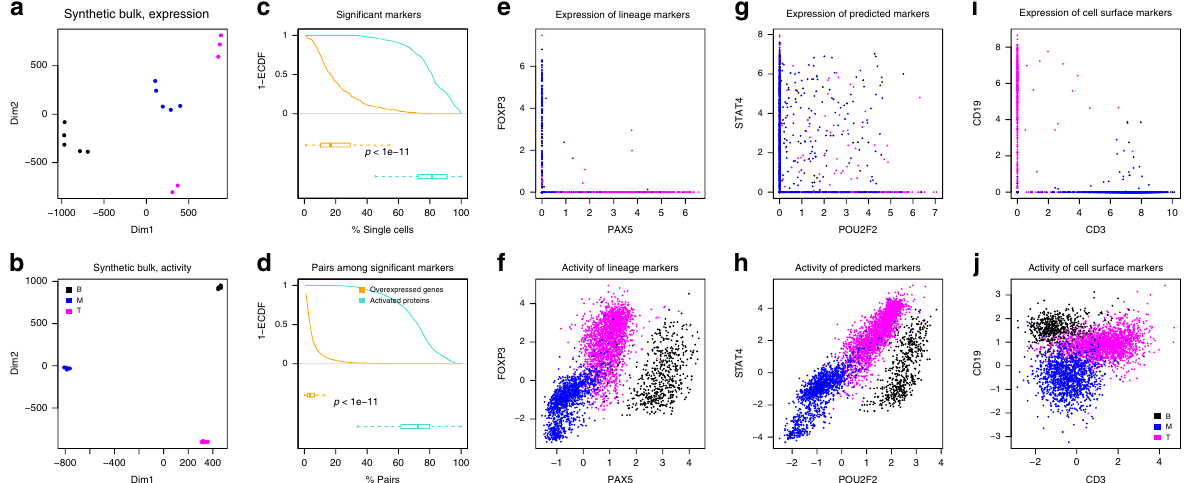
Fig. 4 Comparative analysis of single cell metaVIPER performance compared to gene expression based methods. We identi fi ed the 100 most differentially expressed genes and differentially active proteins based on the analysis of fi ve synthetic bulk samples created by averaging the expression of 100 randomly selected single cells from the melanoma, B cell, and T cell population clusters, respectively. a , b Based on t-SNE analysis, synthetic bulk samples clustered more tightly when analyzed based on VIPER-inferred protein activity than based on gene expression. c This panel shows the percent of the top 100 most differentially expressed genes/active proteins recapitulated as signi fi cantly differentially expressed/active in a given fraction of individual cells against the average expression/activity in a distinct cluster (e.g., a T cell vs. the average of all B cells). The yellow and turquoise curves (1-ECDF) and boxplots (median, lower/upper whiskers, and hinges) summarized the results of RSEM and metaVIPER-based analyses, respectively. d The same analyses were repeated to assess reproducible differential expression/activity of a gene/protein pair, as relevant for virtual FACS analyses. e , f Virtual FACS analyses using expression and activity of established lineage marker TFs by RSEM and metaVIPER-based analysis (see main text and Fig. 3 for details). g , h Virtual FACS analysis using expression and activity of STAT4 and POU2F — both identi fi ed as differentially expressed and active candidate biomarkers from bulk sample analyses — using the same methods. i , j Virtual FACS analysis based on expression and activity of CD3 and CD19 cell surface markers, as used in standard FACS analyses, using the same